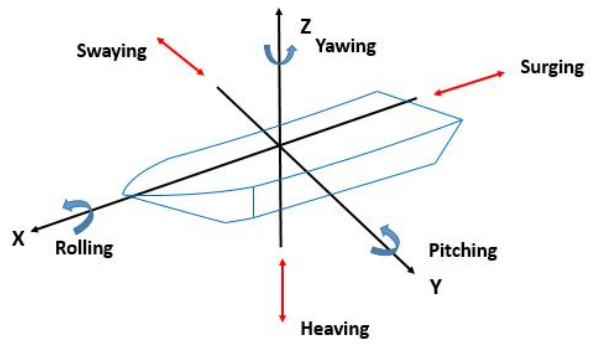
Figure 1. Six-Dof movements of a ship during sea transportation.